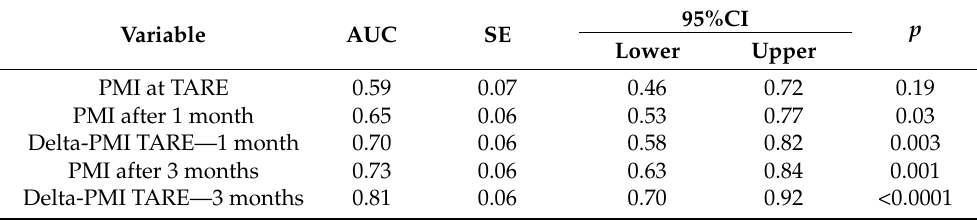
Table 3. Diagnostic ability for progressive disease of the different sarcopenia